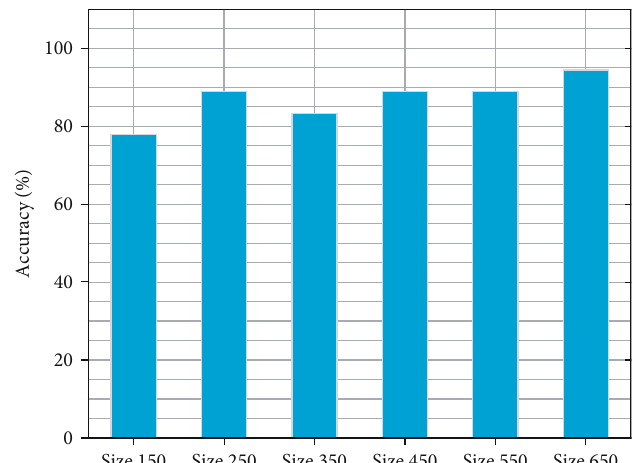
Figure 5: The accuracy of detecting the noxious stimulation during anesthesia with di ff erent window